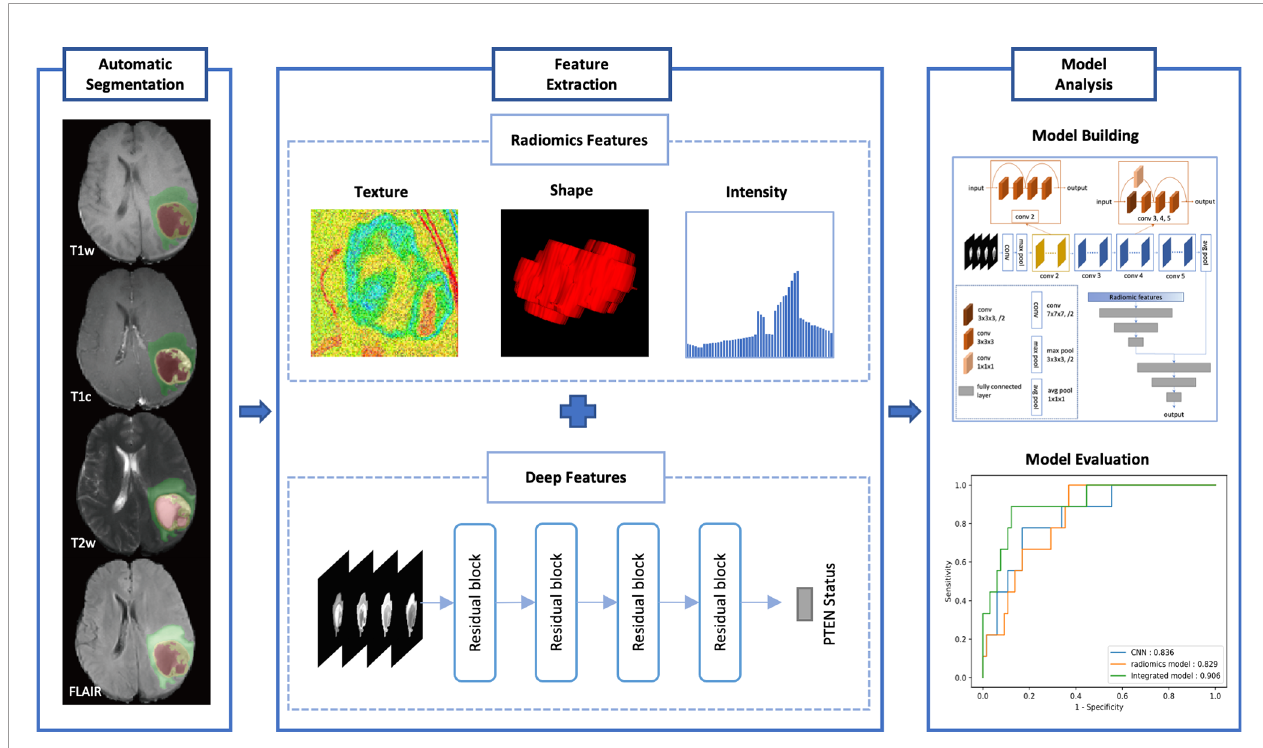
FIGURE 1 | The design of our study.